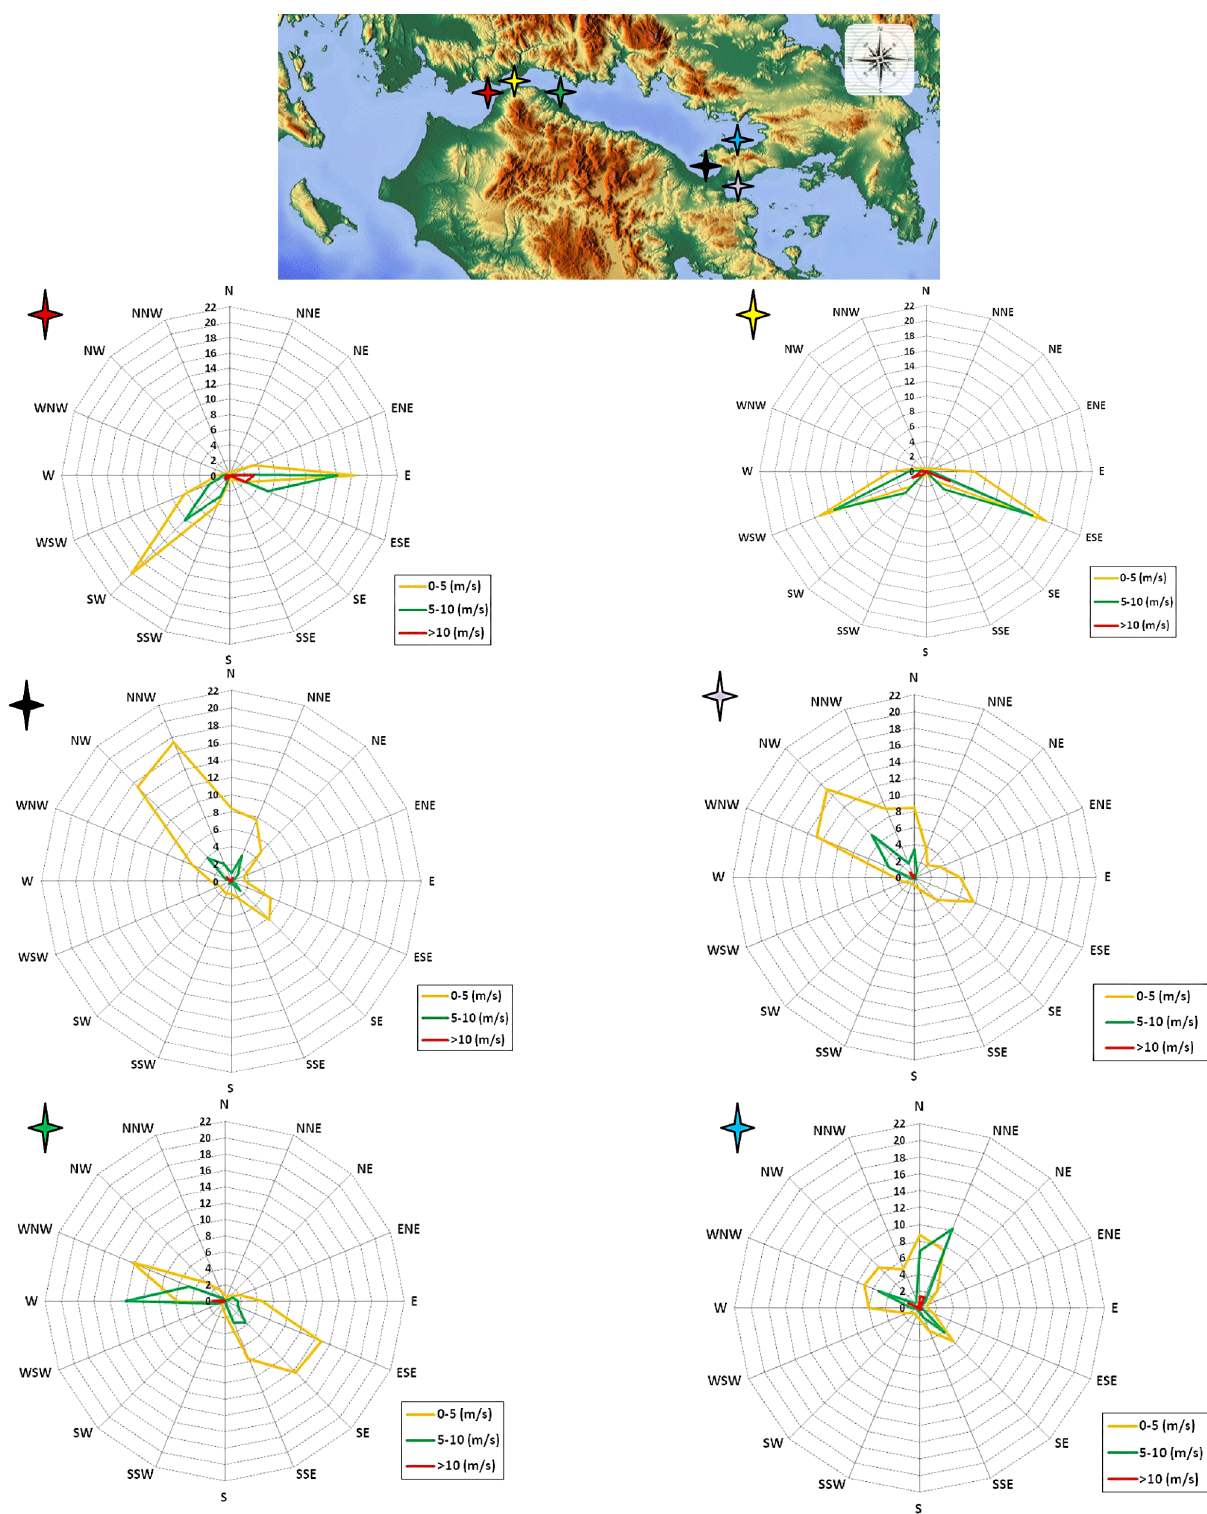
Fig. 4. Wind roses at six locations denoted by colored four-point stars on the area map. Three different wind speed categories are included in each wind rose: light (orange line, 0–5ms − 1 ) , moderate (green line, 5–10ms − 1 ) , and strong winds (red line, >10ms − 1 ) . Rings are drawn at 2%